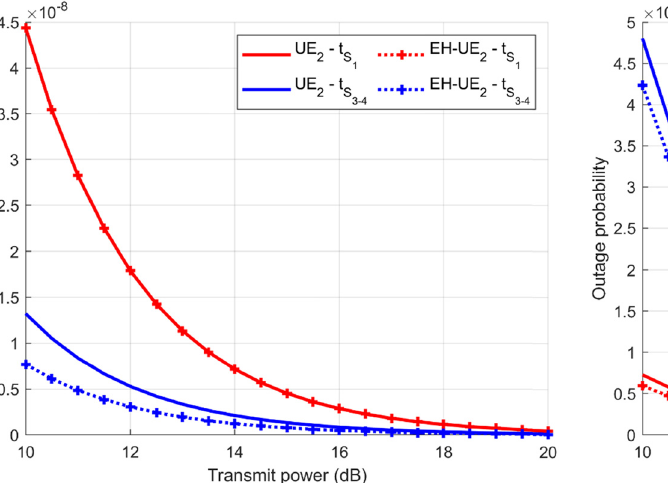
Figure 4: Outage probability of user 2.